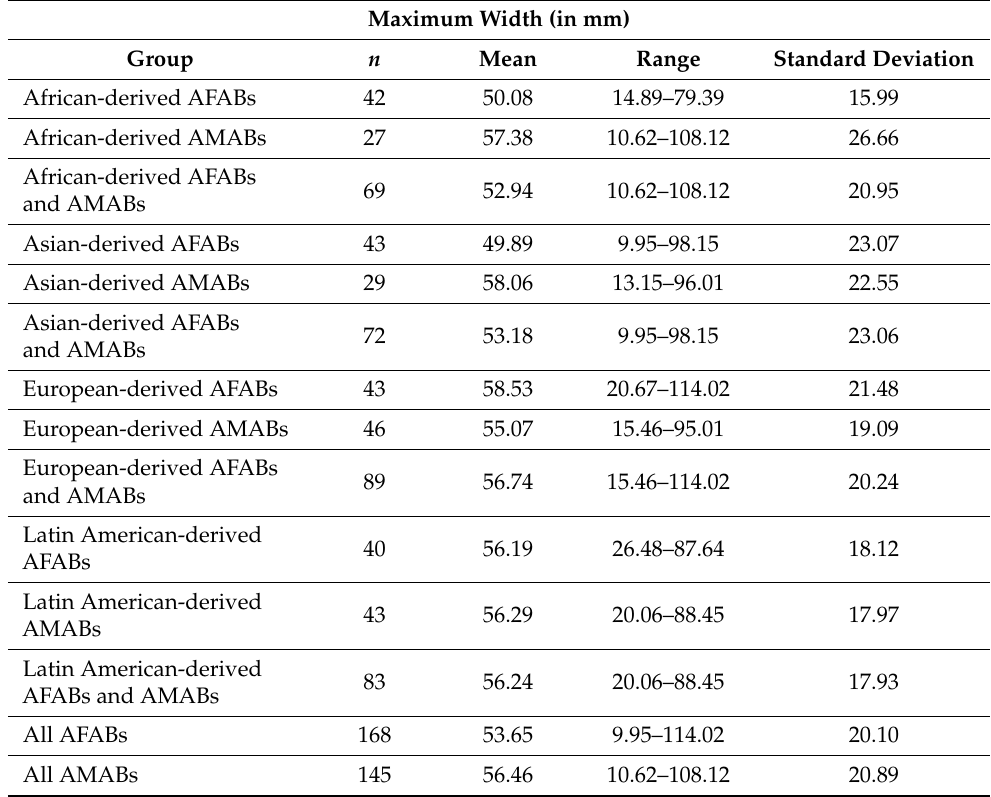
Table 6. Descriptive statistics for the frontal sinus maximum width by population affinity and assigned